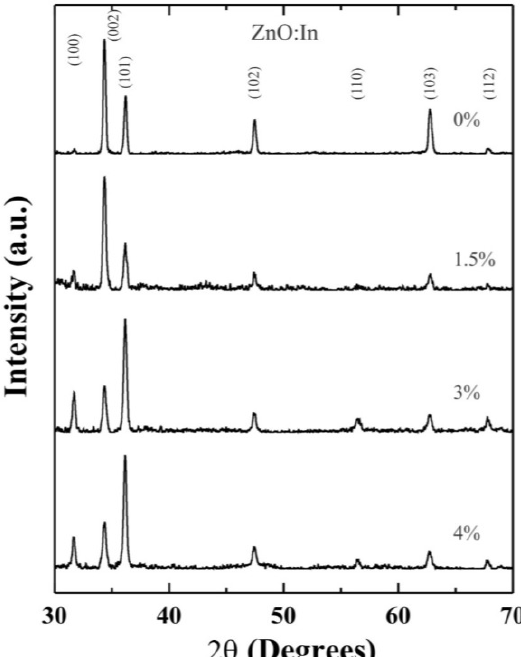
Figure 1. XRD patterns of ZnO:In thin films containing different nominal indium concentrations deposited at T = 450 s